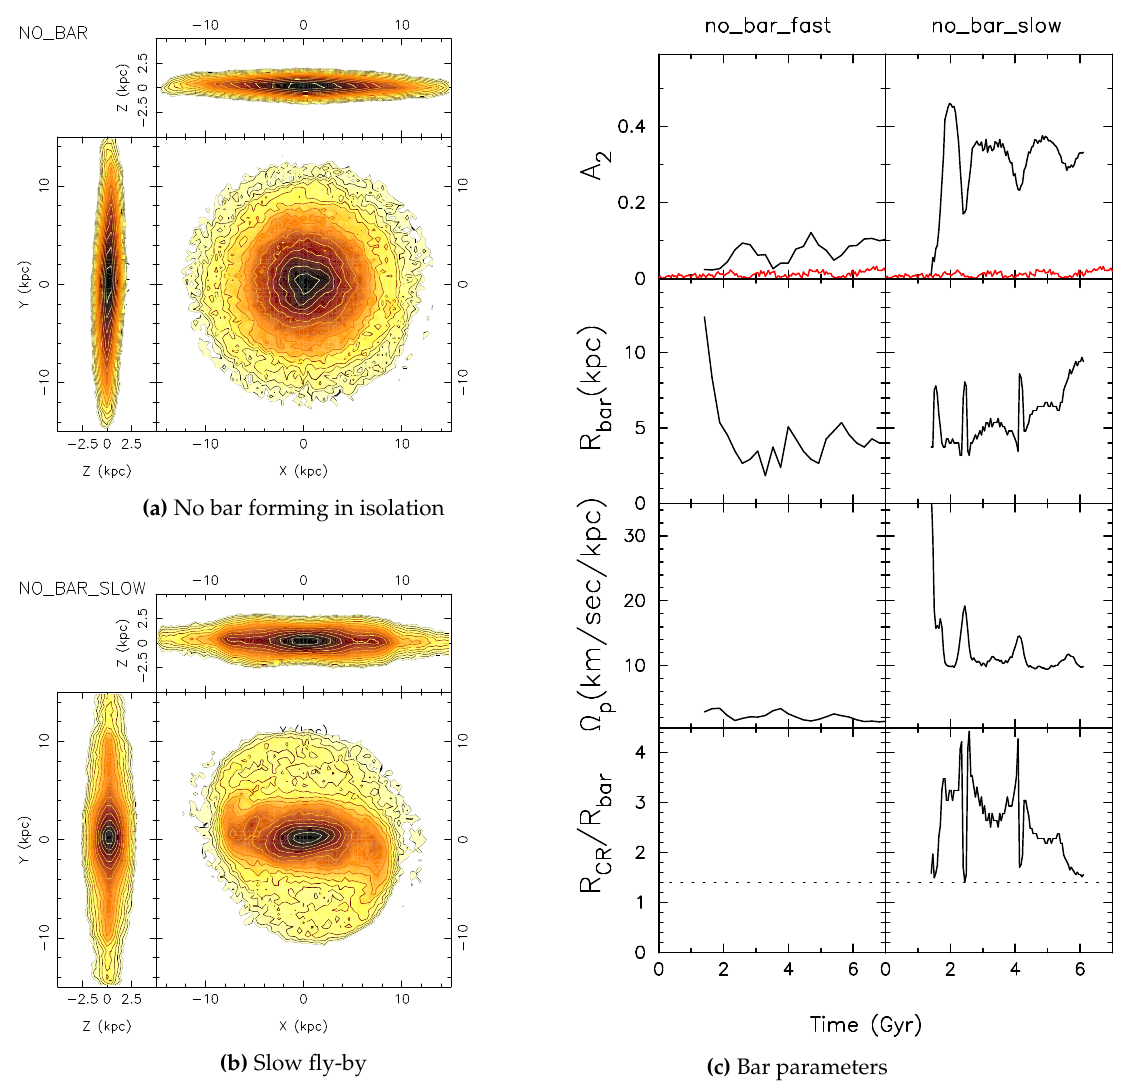
Figure 2. Left : Stellar density maps in three spatial projections of the simulation with no bar in isolation ( no bar case ). The original simulation is plotted on the top left, and below we plot the resulting galaxy after the slow interaction. The time shown is τ = 4.18 Gyr. Right : Time evolution of bar parameters for the fast and slow encounter. The red line represents the evolution of the original galaxy in